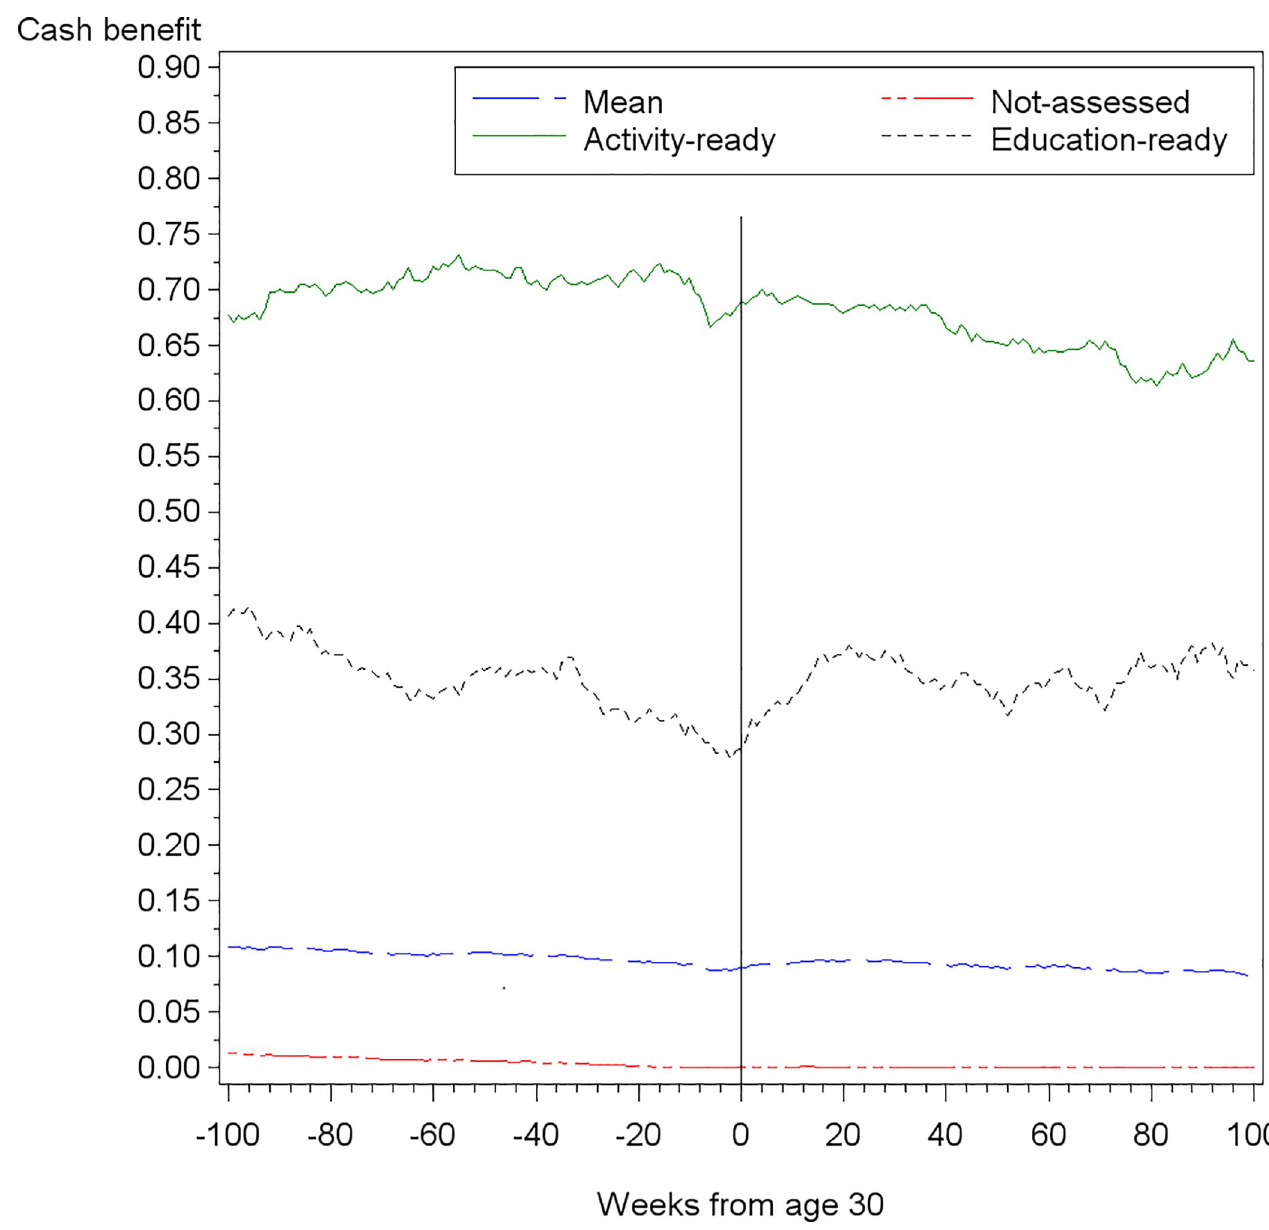
Fig 2. Mean share of cash benefit recipients among young adults with low qualifications, by assessment